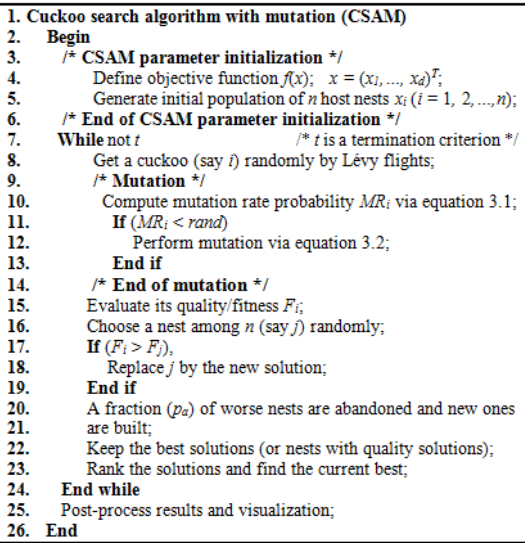
Figure 4: The general pseudo–code for